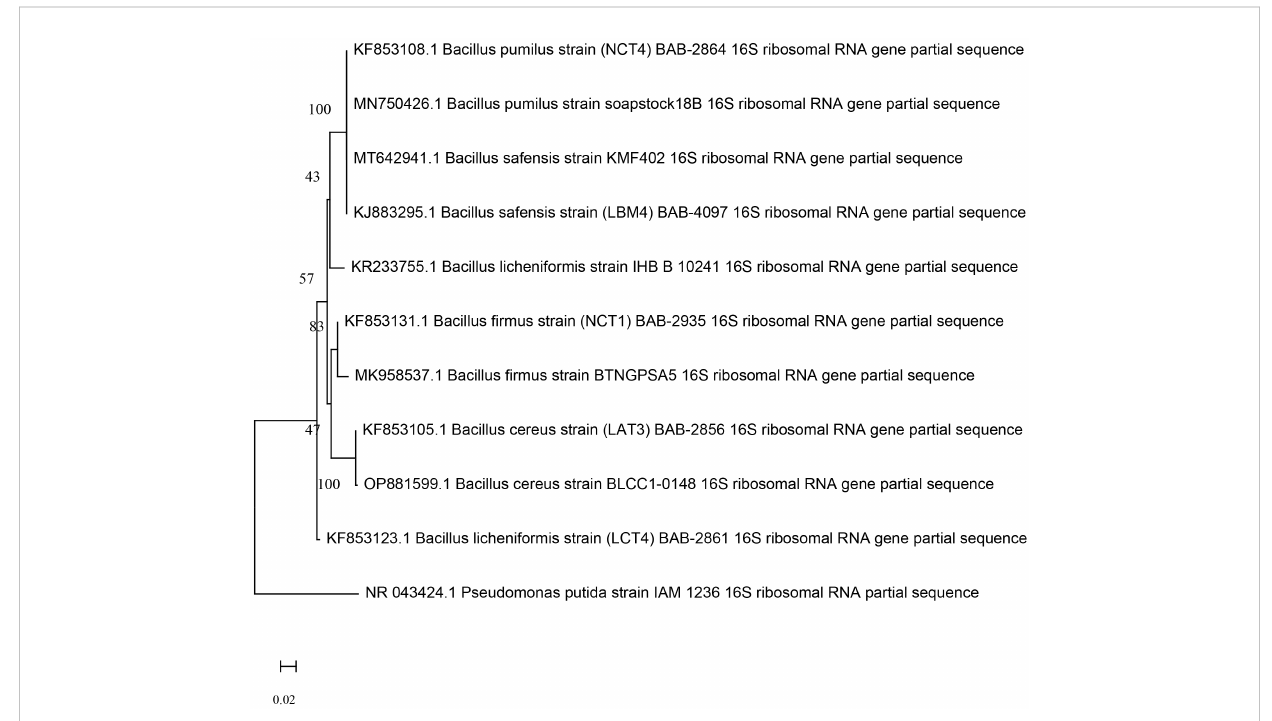
FIGURE 1 Phylogenetic relationship among the KF853108 Bacillus pumilus strain (NCT4), KJ883295 Bacillus safensis strain (LBM4), KF853123 Bacillus licheniformis strain (LCT4), KF853105 Bacillus cereus strain (LAT3), KF853131 Bacillus fi rmus strain (NCT1) and other type strains based on 16S rRNA gene sequences generated by neighbor end joining